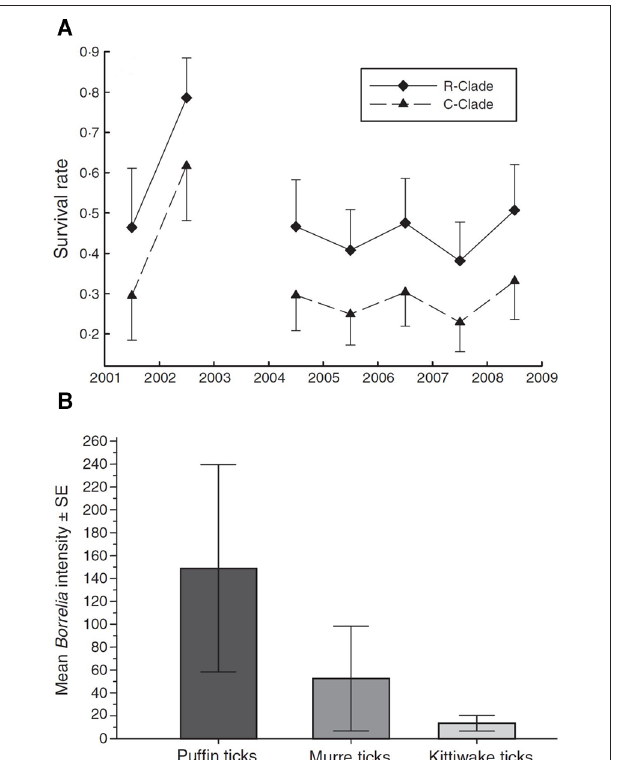
of avian malaria ( Plasmodium relictum ◆ R-clade; P. circumflexum ▲ C-clade). (Adapted from Lachish et al. (21), with the permission of John Wiley and Sons ); (B) Intensity of infection of Lyme borreliosis bacteria (mean spirochetes ± SE) in three morphologically cryptic avian tick races associated with puffins, murres, and kittiwakes. [Adapted from ( 39 ), with the permission of John Wiley and Sons